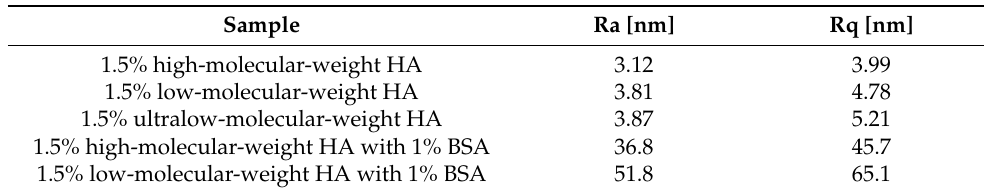
Figure 8. AFM visualization of the surface of film obtained from the solution of 1.5% low-molecular HA with 1% BSA. Table 6. Ra and Rq values for films obtained from high, low, and ultralow HA and mixtures of HA with BSA.